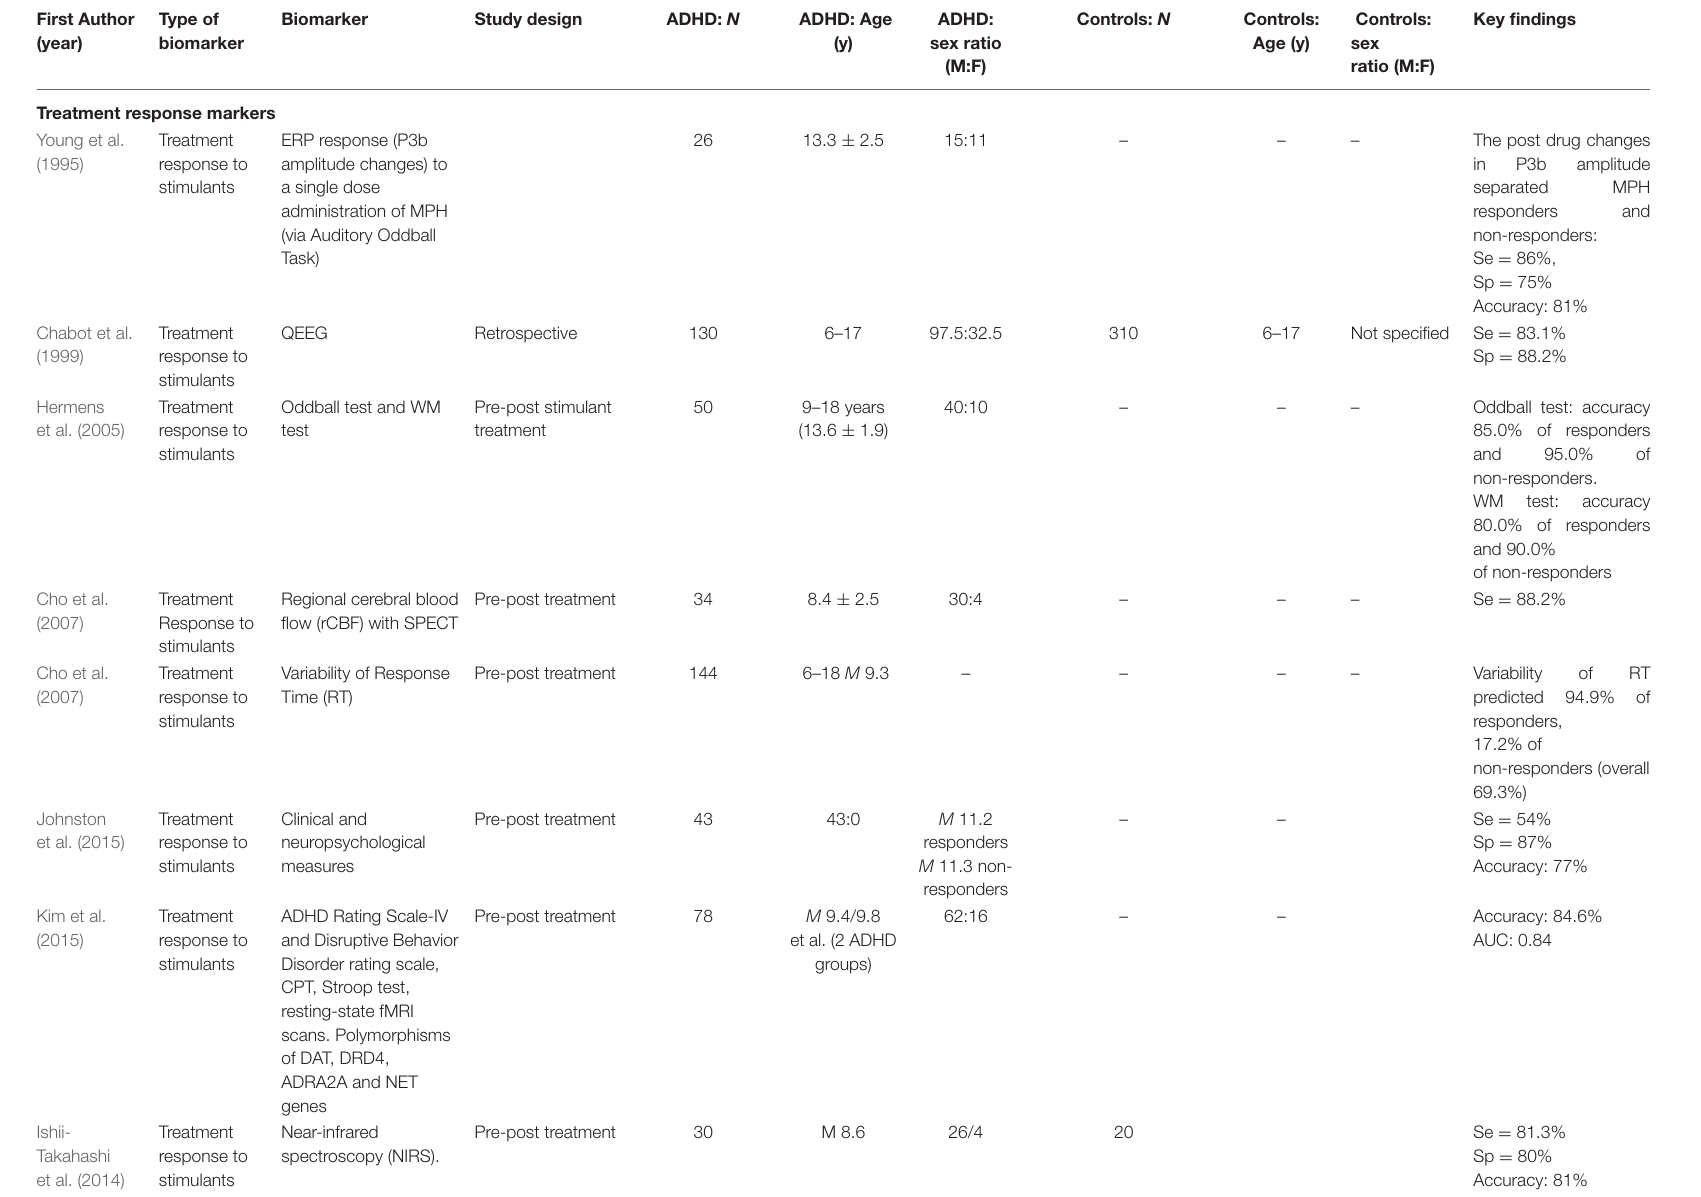
TABLE 3 | Treatment response and subtyping